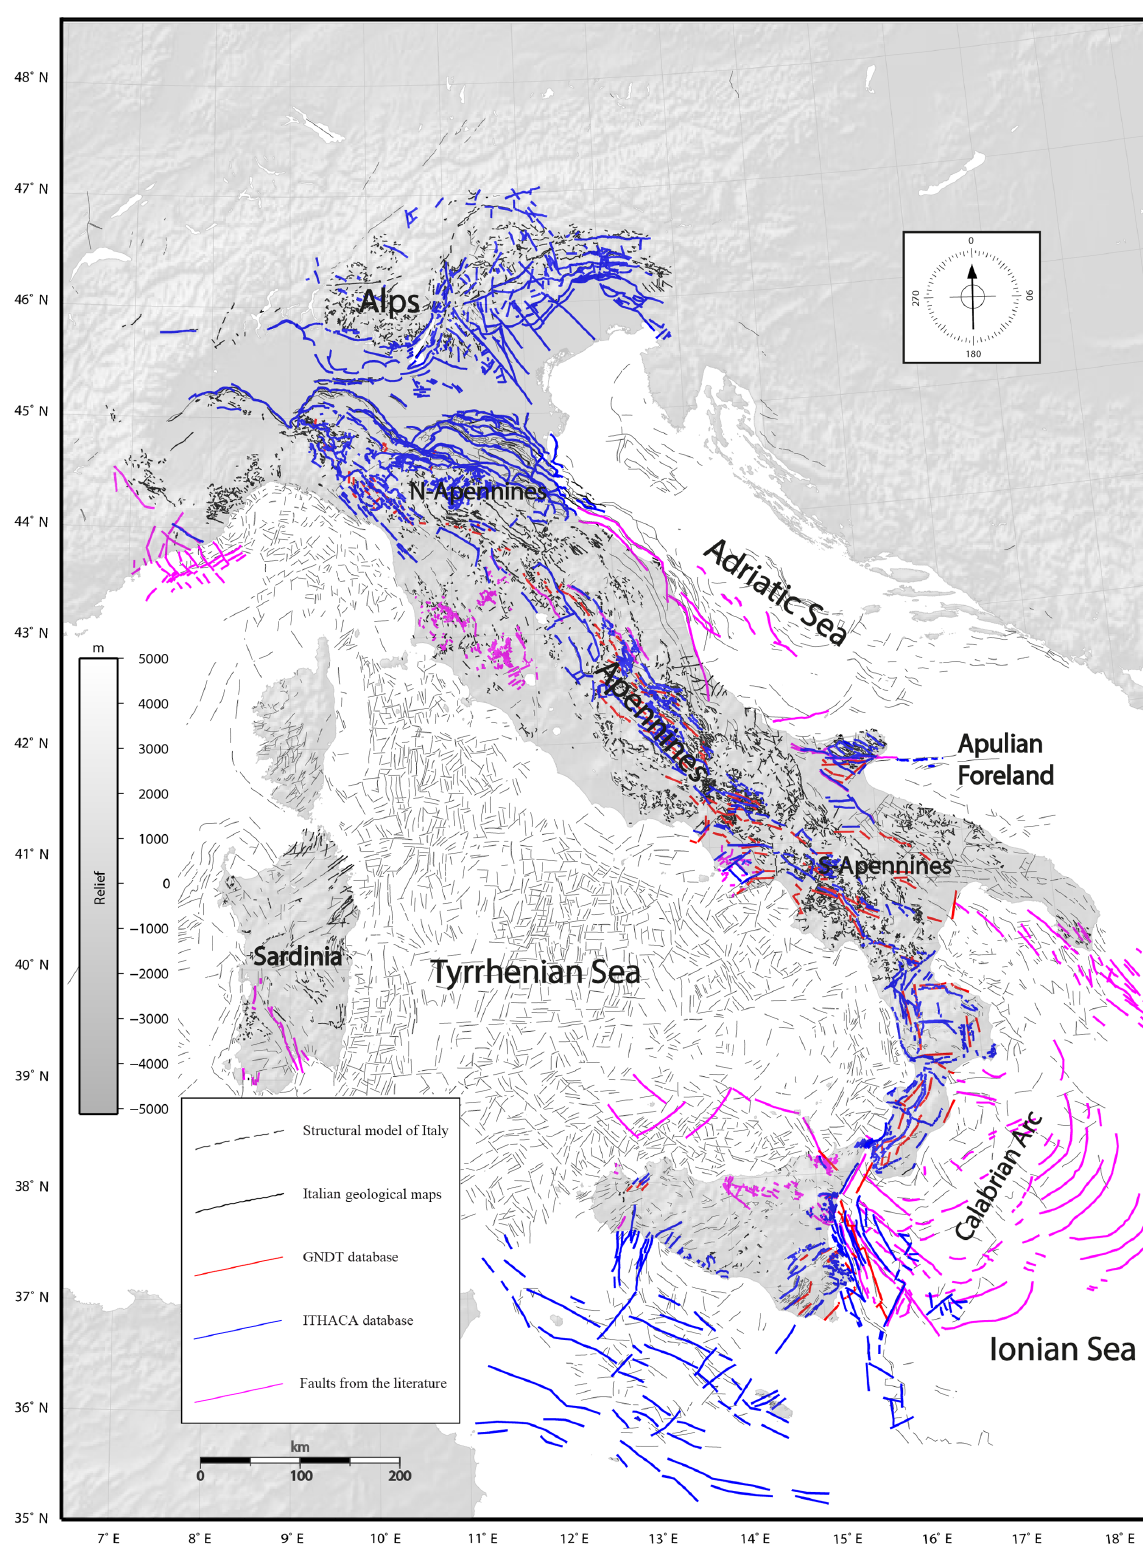
Figure 2. Map of faults from the five datasets used in this work: the Structural Model of Italy at the 1 : 500000 scale (dashed black; Bigi et al., 1989); the Italian geological maps at the 1 : 100000 scale (black; available online at http://www.isprambiente.gov.it/it/cartografia/, last access: 29 August 2019); the GNDT database of active faults (red; Galadini et al., 2000); the ITHACA database (blue; Michetti et al., 2000); and selected active faults from complementary studies published by different authors (pink; see text for